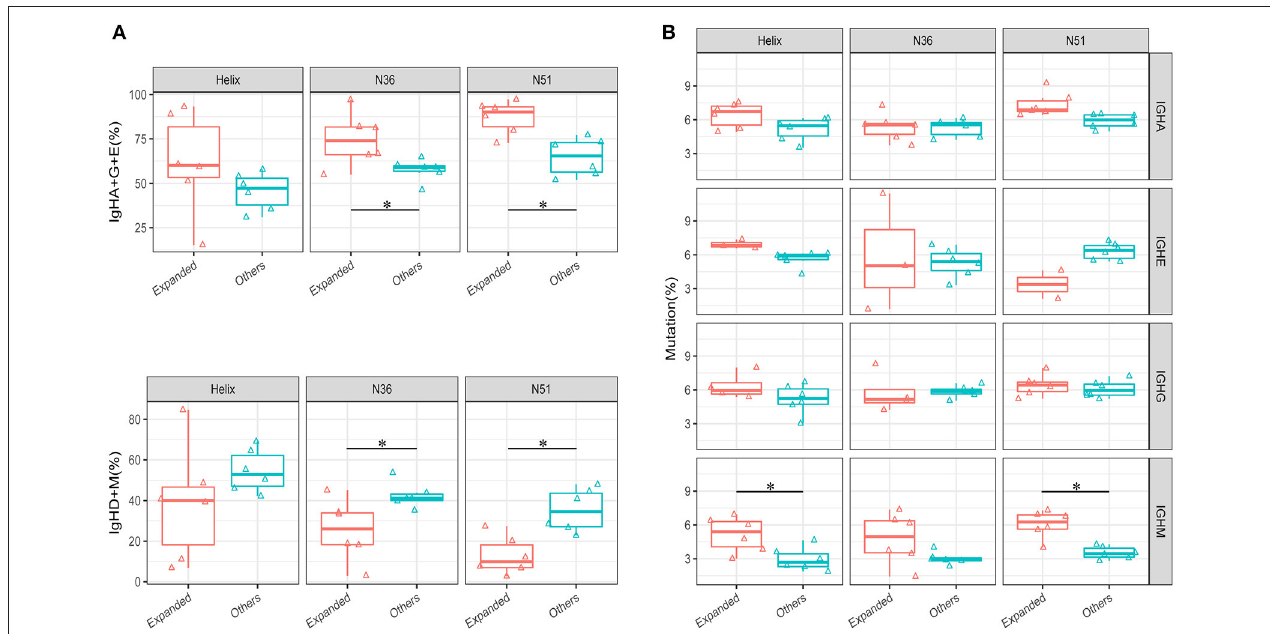
FIGURE 4 | Comparison of the isotype-switch and mutation rates of the lineages at D0. (A) The comparisons of percentages (IgH type A, G, and E are shown combined in the upper panel, IgH type M and D shown combined in the lower panel) between vaccination-induced (expanded) lineages and all other lineages in each vaccination group. (B) The comparison of average mutation rates for IgHA, IgHE, IgHG, and IgHM between vaccination-induced lineages, and all other lineages in each vaccination group. Comparison were performed using paired Wilcoxon test. * P <